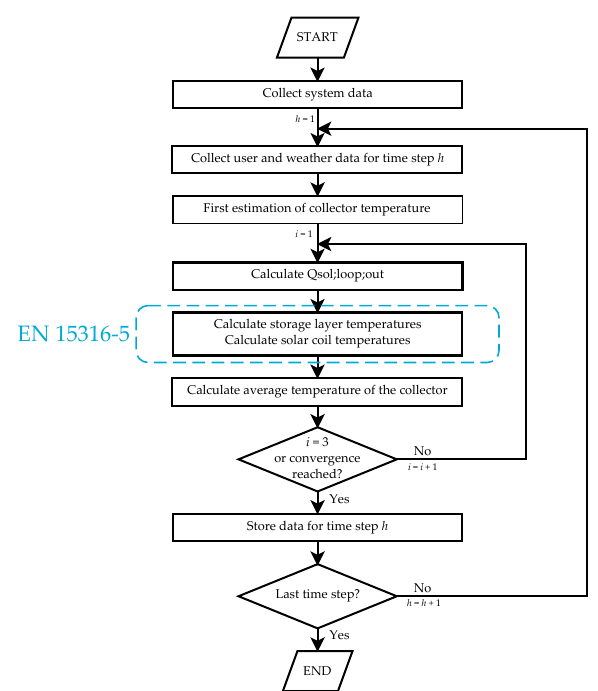
Figure 3. Diagram for hourly calculation according to EN 15316-4-3 and EN